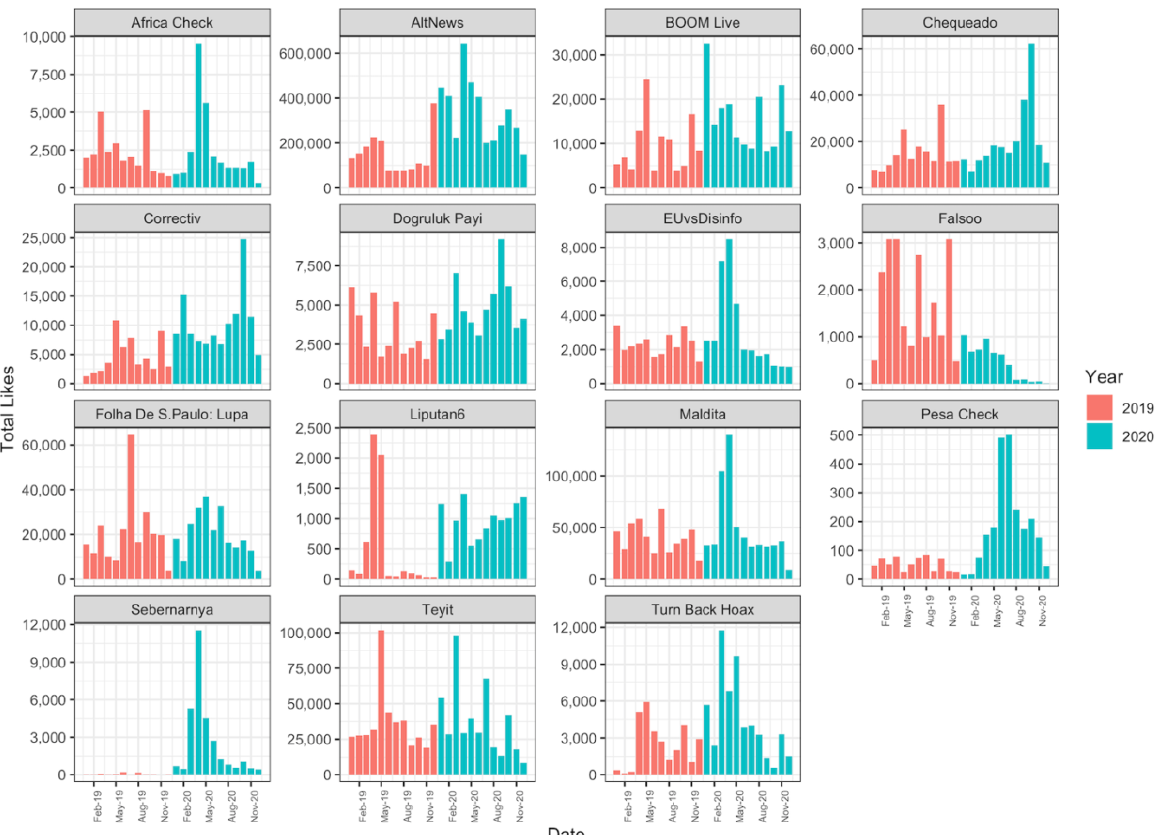
Figure B2. Distribution of userlLikes on fact-checking content. The user engagement measured as likes on fact-checking content in 2019 and 2020 is shown as a time